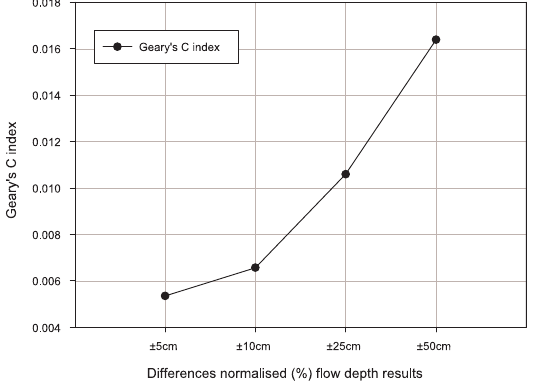
Fig. 8. Geary’s autocorrelation spatial index the percentages of dif- ferences normalised of flow depth results using each scheme com- pared with those obtained using a reference one (Ref).